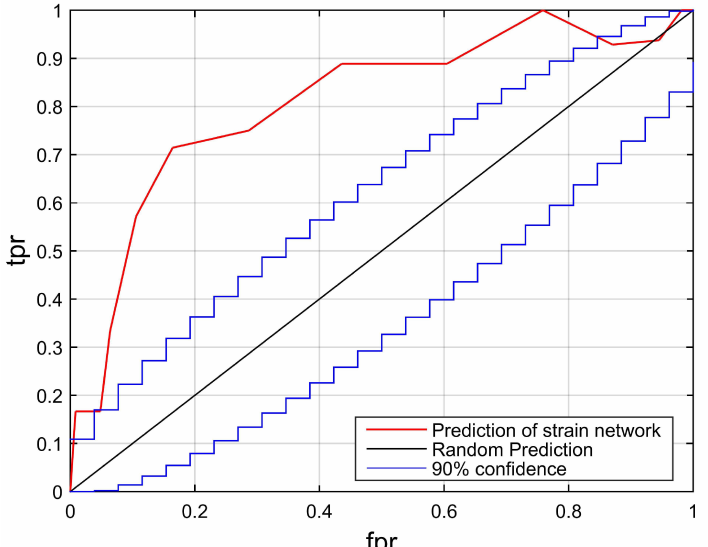
Figure 5. Receiver operating characteristic (ROC) curve used to detect the relationship between the network degree and the earthquakes with E s ≥ 10 7 . The black diagonal line shows prediction by random guessing, whereas the blue steps provide 90% confidence intervals for the random prediction. The red solid line indicates the prediction result for N ano = 7 and T alm = 1 days. For this prediction, the AUC (Area Under the ROC Curve) was